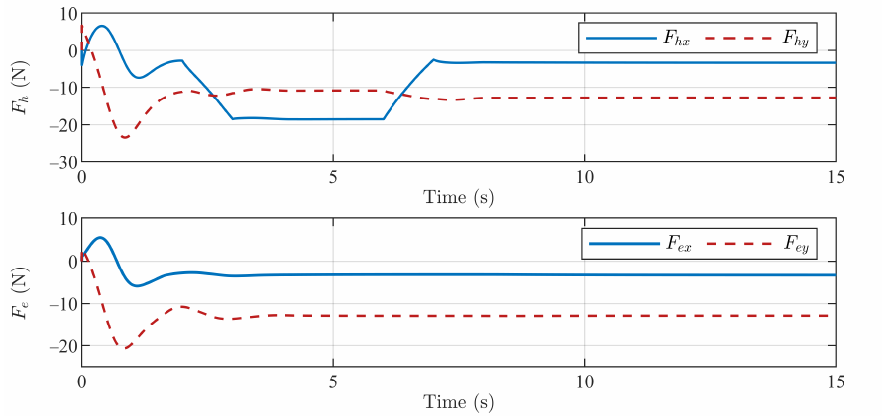
Figure 6. Results of operator force and environmental force.